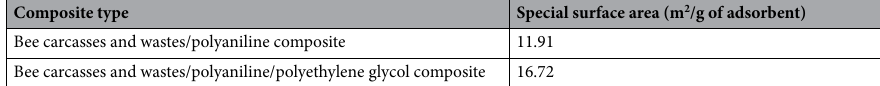
Table 2. Results of BET analysis for bee carcasses and wastes and polyaniline composites.